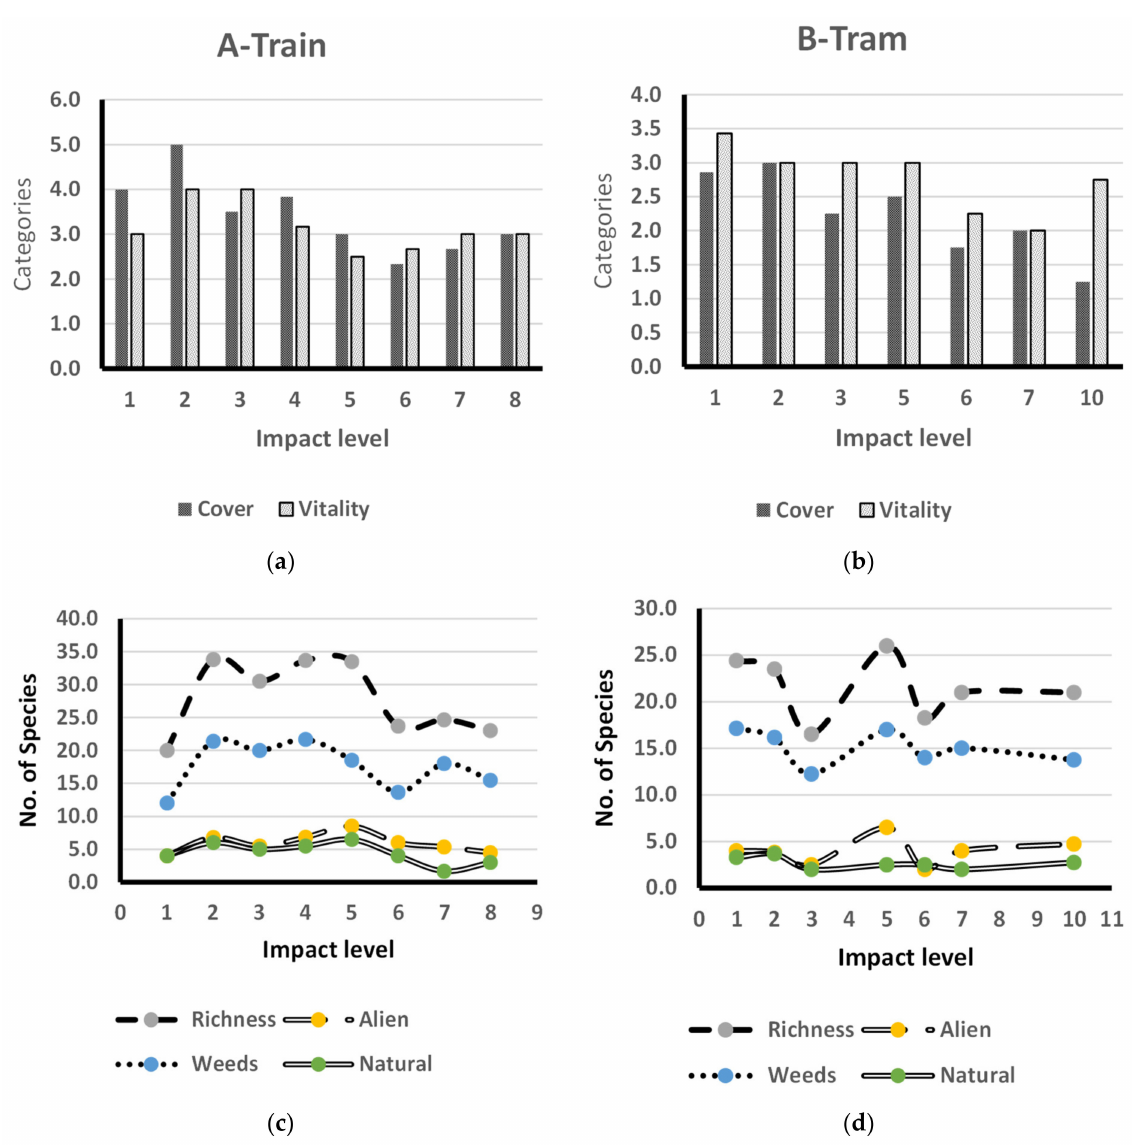
Figure 7. Species richness, number of alien species, weeds, natural species, cover, and species vitality across human impact levels along the train railway ( a , c ) and tram tracks ( b , d